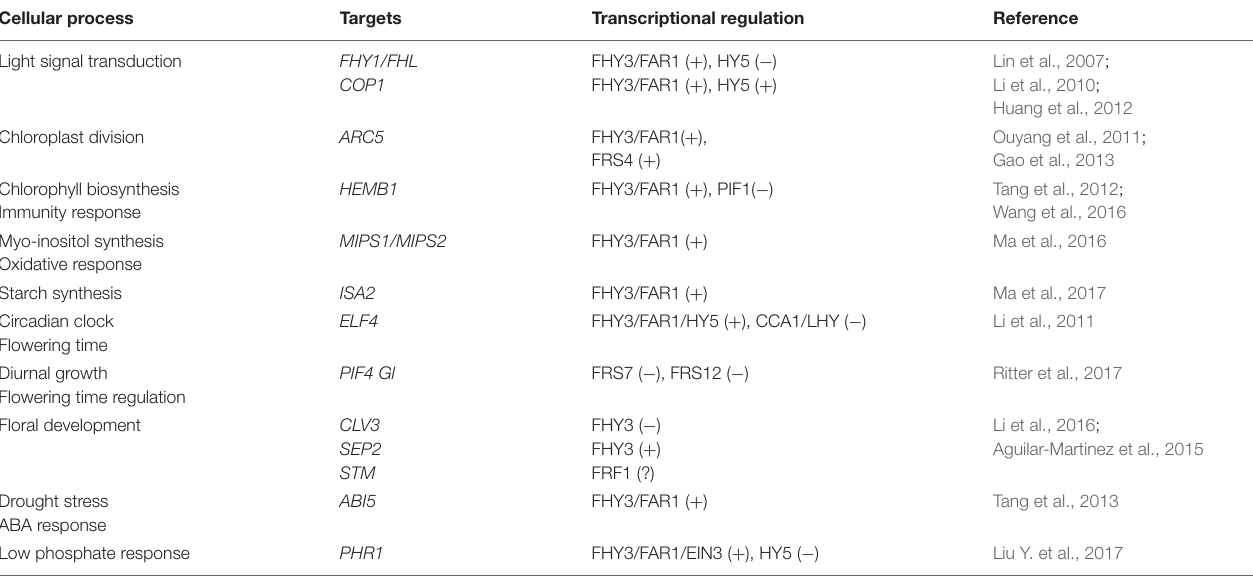
TABLE 1 | The physiological functions of FRS-FRF family proteins in Arabidopsis